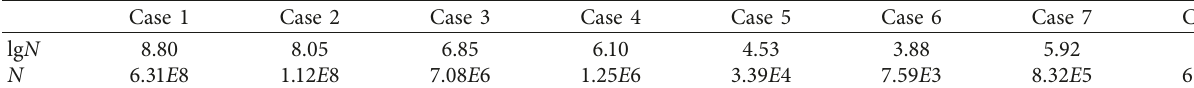
Table 9: Statistical list of fatigue life in various cases.